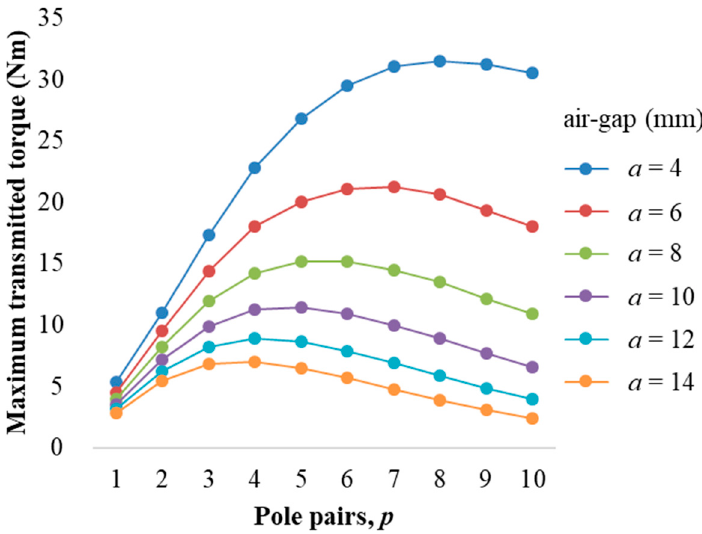
Figure 9. The maximum transmitted torque versus the number of pole pairs.